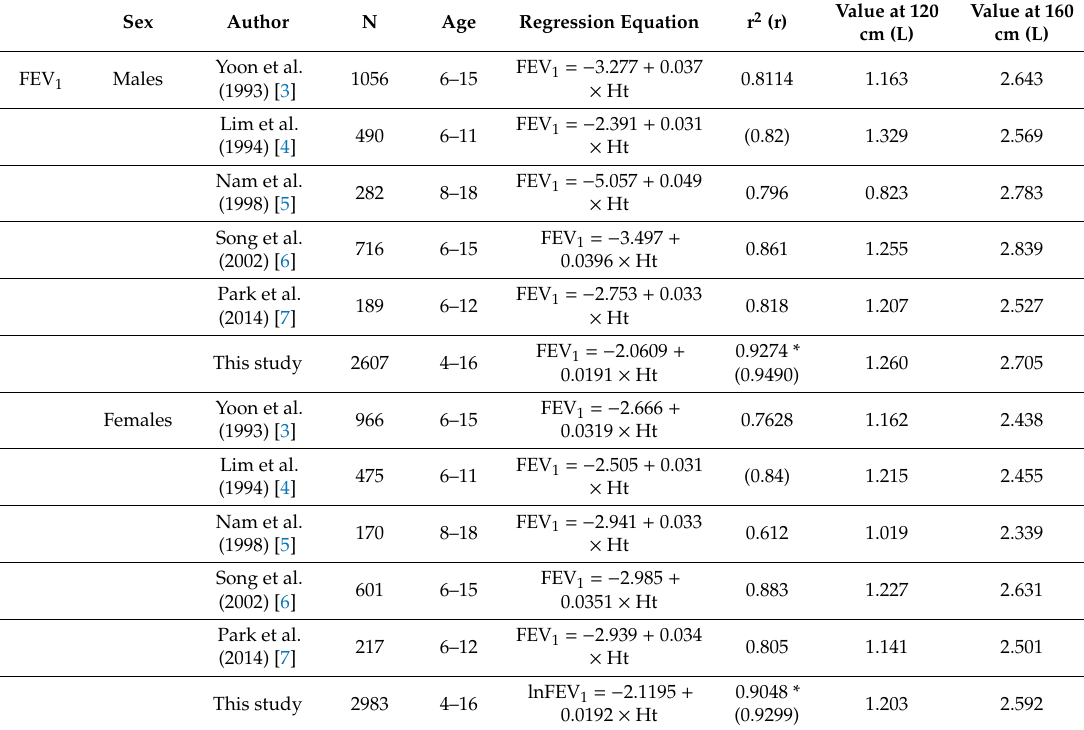
Table 4. Comparison of predicted values of the FEV 1 and FVC with previous Korean